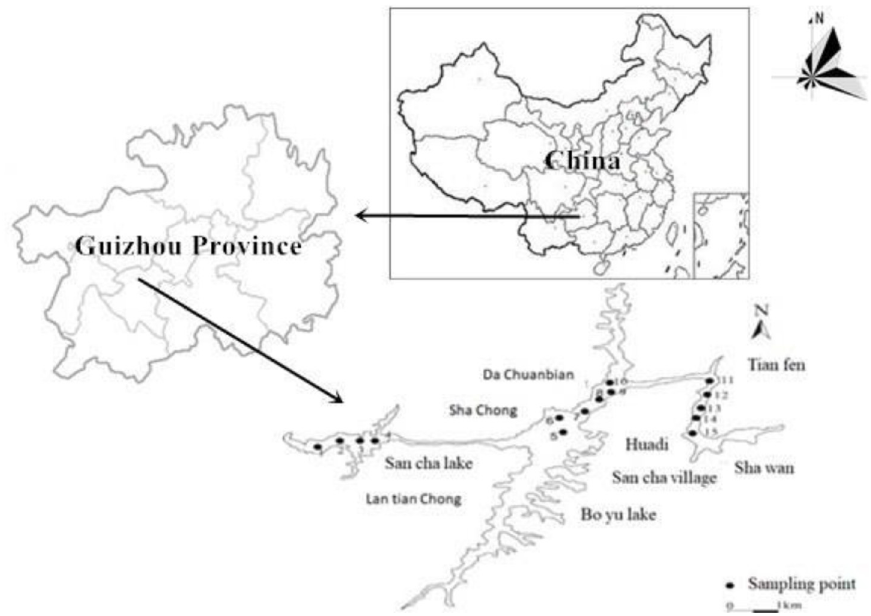
Figure 1. Distribution of sampling sites at Yelang reservoir in Guizhou province.